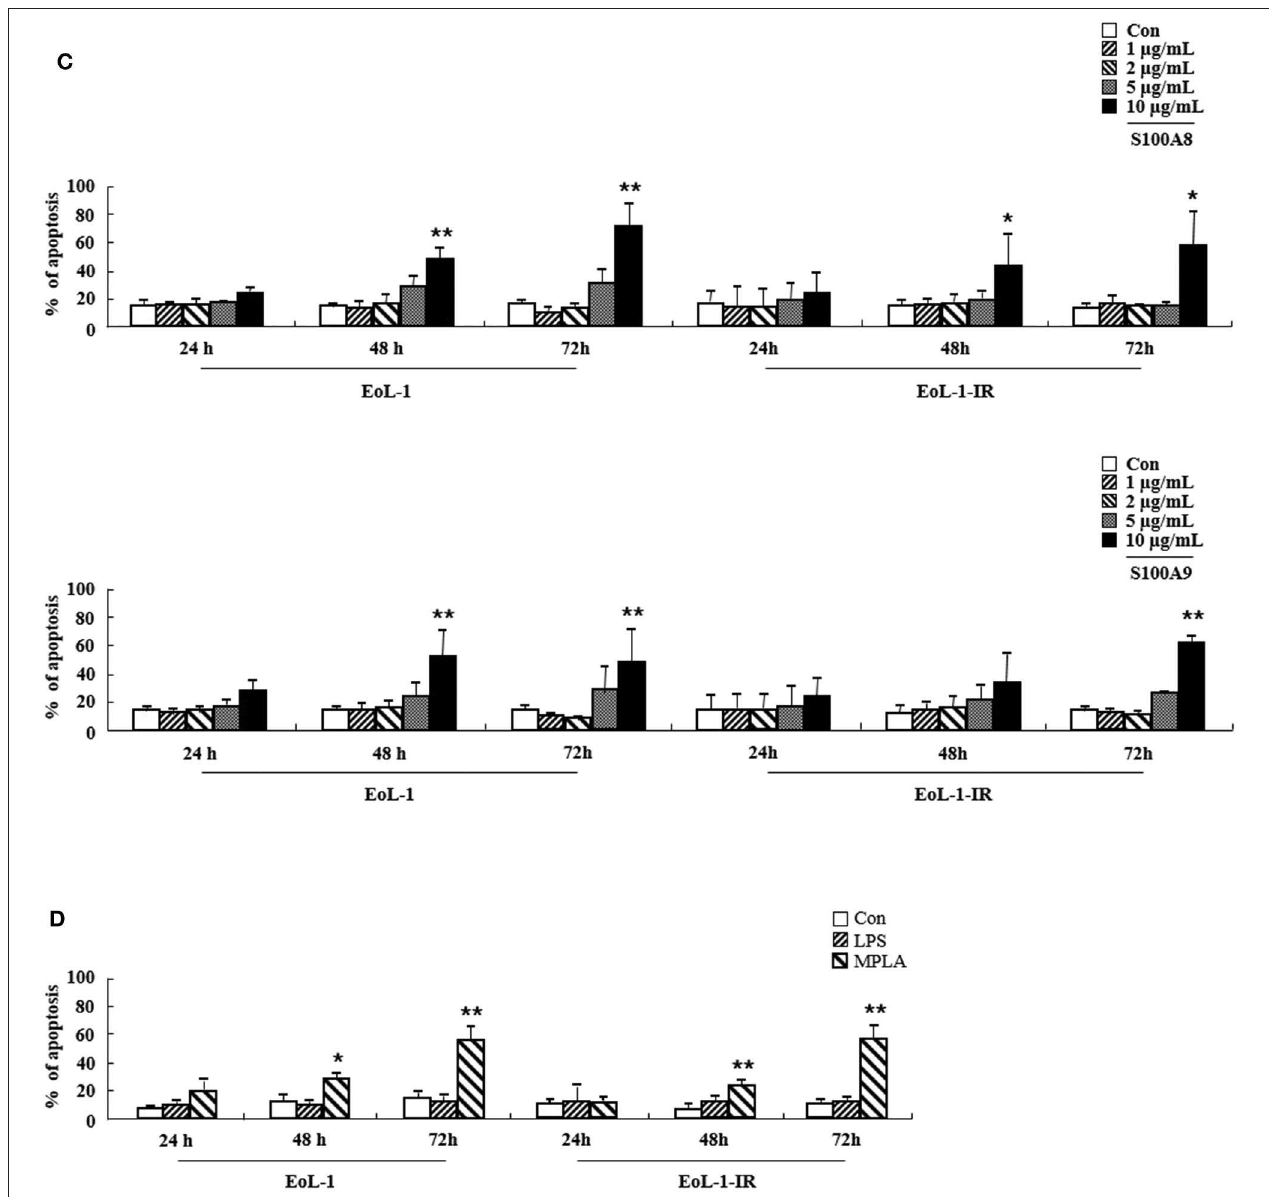
and Western blotting. The xenografted cells multiplied in a time-dependent manner, and tumor volume and weight were observed to decrease after administration of S100A8 and S100A9 ( Figures 5A,C ). Although tumor sizes differed in EoL-1 and EoL- 1-1R cells due to initial inoculation of different cell numbers, the effects of S100A8 and S100A9 did not show specific differences. Results from immunohistochemistry and Western blotting confirmed that exposure to S100A8 and S100A9 reduces the phosphorylation of PDGFR α by decreasing the PDGFR α expression ( Figures 5C,F,G ). The treated group also shows diminished activation of Stat 3, Stat 5, AKT, ERK, p38 MAPK,